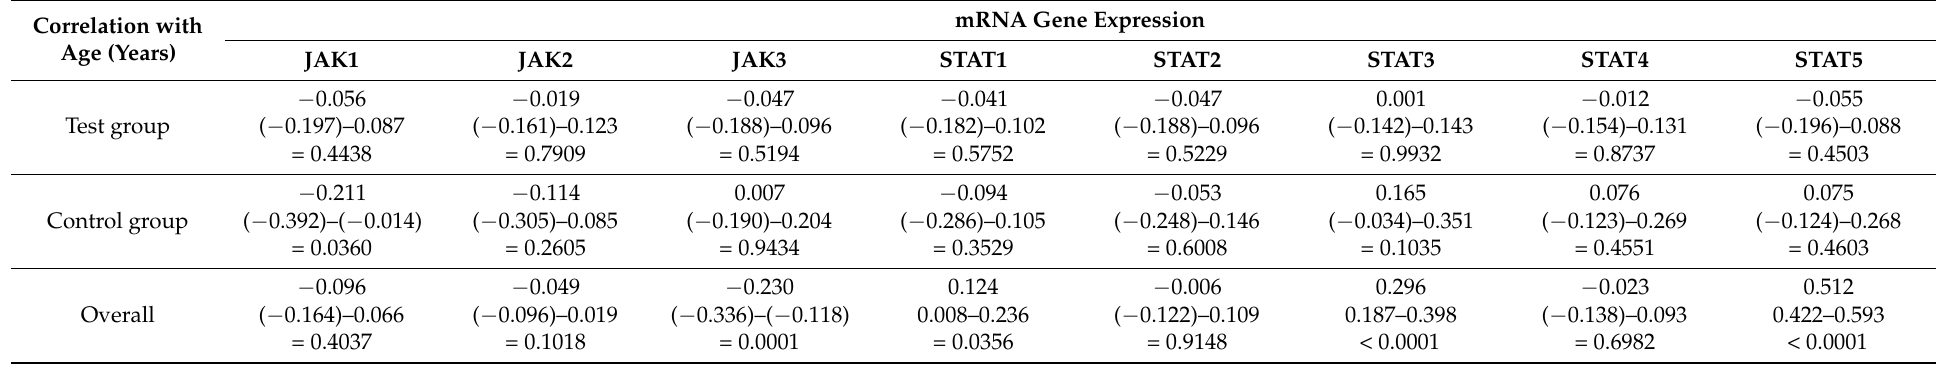
Table 5. Pearson product–moment correlation coefficients, their confidence limits and levels of statistical significance for the mRNA gene expression vs. patients’ age in study